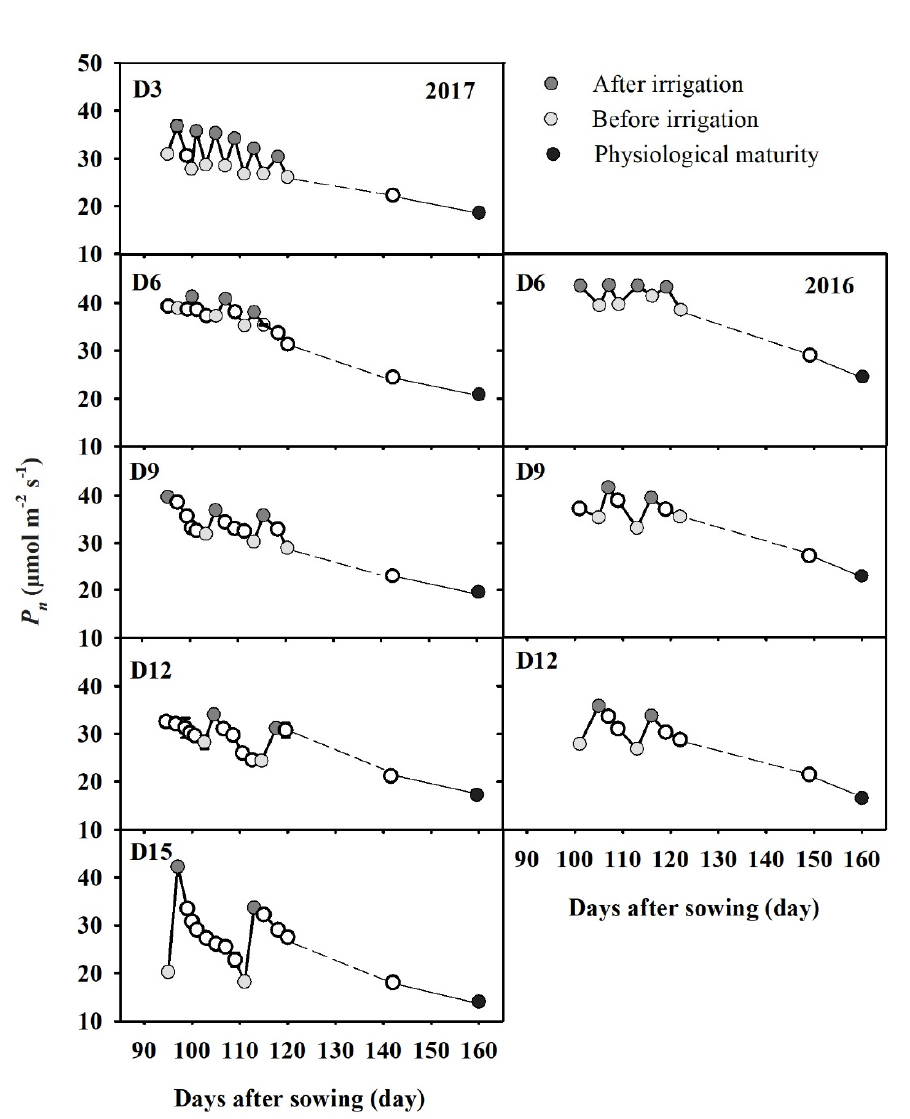
Figure2. Changesofleafphotosyntheticrateofmaizeunderdifferentirrigationintervals. Figure 2. Changes of leaf photosynthetic rate of maize under different irrigation intervals. The abbreviations “D X ” represent irrigation intervals of X days (e.g., “D6” represents an irrigation interval of six days).